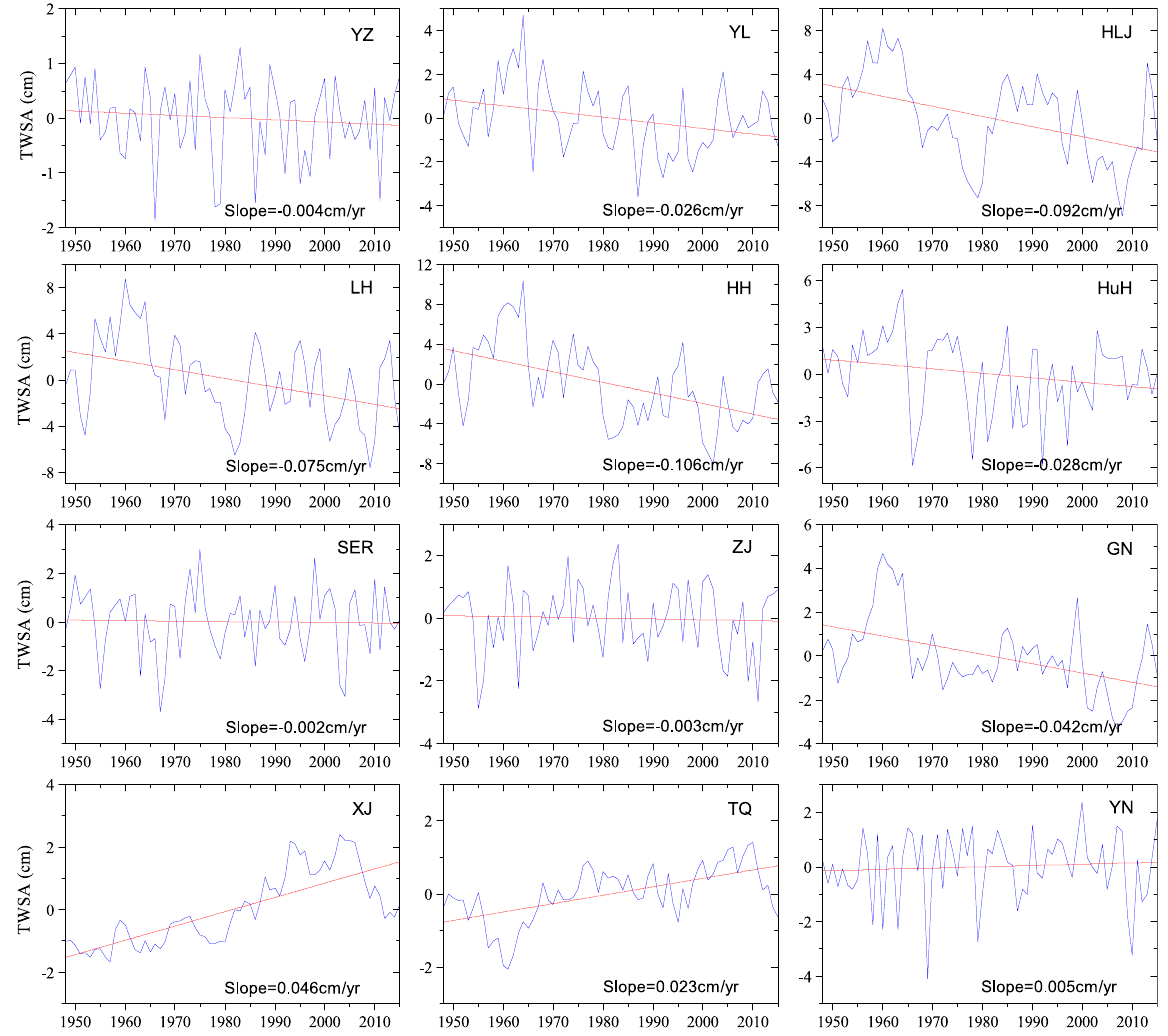
Figure 3. Long term changes of TWSA in key zones (YZ, YL, HLJ, LH, HH, HuH, SER, ZJ, GN, XJ, TQ and YN) from 1948 to 2015. This result was performed using Origin 9.0